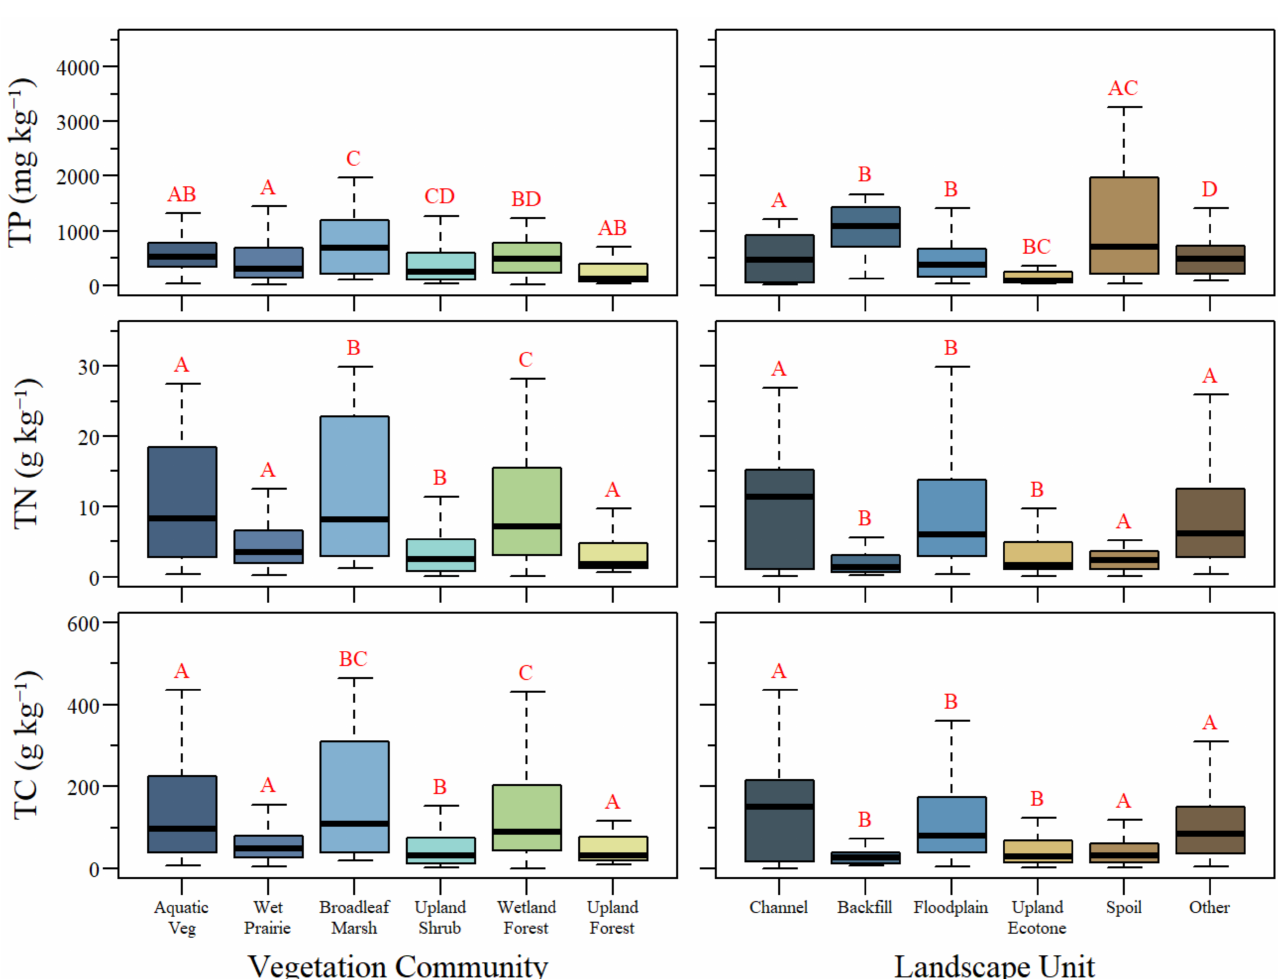
Figure 5. Surface sediment total phosphorus (TP, top ), total nitrogen (TN, middle ) and total carbon (TC, bottom ) boxplots grouped by vegetative community ( left ) and landscape unit ( right ). The letters above boxplots indicate statistically significant differences between groups for each parameter. Vegetative community and landscape unit were tested